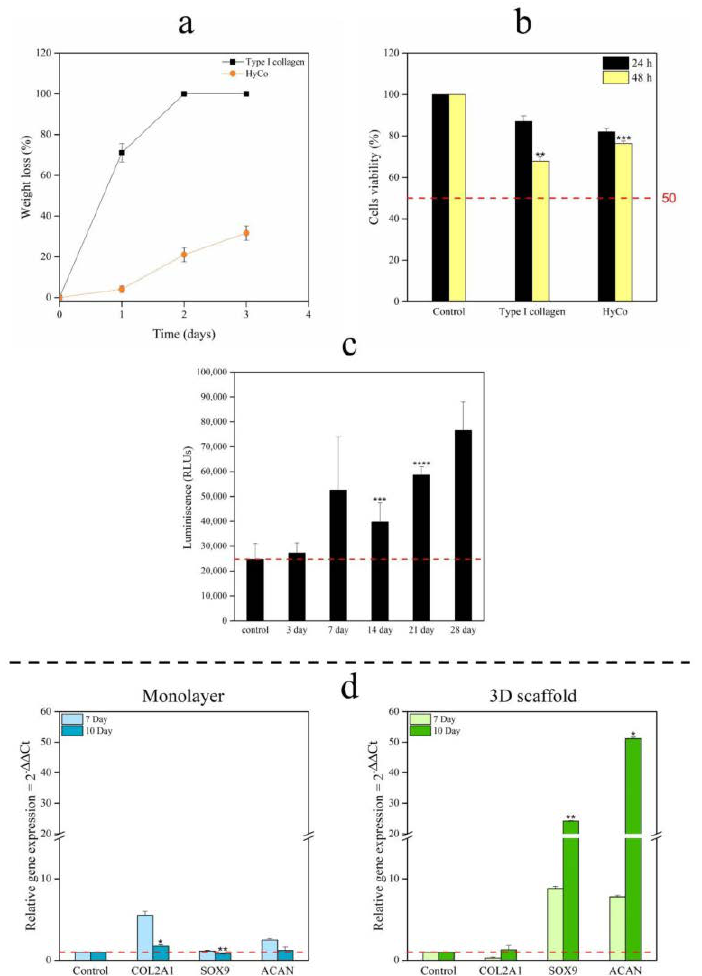
Figure 6. Degradation profiles of commercial collagen scaffold and HyCo, cytotoxicity study, and gene expression profiles. Comparison between enzymatic degradation of collagen and HyCo following treatment with collagenase from Clostridium hystolyticum , at 37 ◦ C ( a ); Collagen and HyCo scaffolds cytotoxicity evaluated with human peripheral blood mononuclear cells (hPBMCs) by MTT assay: the histograms report the mean percentage of viable cells compared to controls of untreated cells ( b ). ATP activity of human chondrocytes cultured on HyCo scaffold for 28 days evaluated as mean of relative luminescence units compared to control. Experiments were analyzed by two-tailed Student’s t -test, * p ≤ 0.05, ** p < 0.01, *** p < 0.001 and **** p ≤ 0.0001; N = 3 ( c ); mRNA expression levels